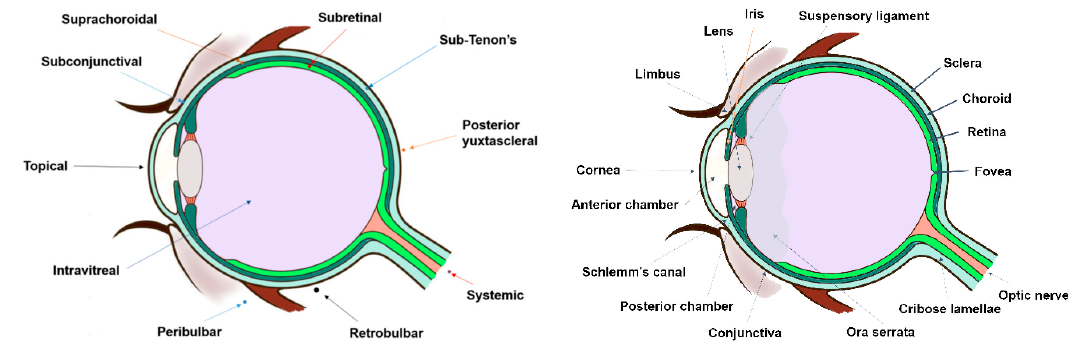
Figure 2. The first image represents a scheme of the different routes of drug administration to the posterior segment (dots symbolize the injection site of each route), while second image exemplifies the anatomy of the eye.